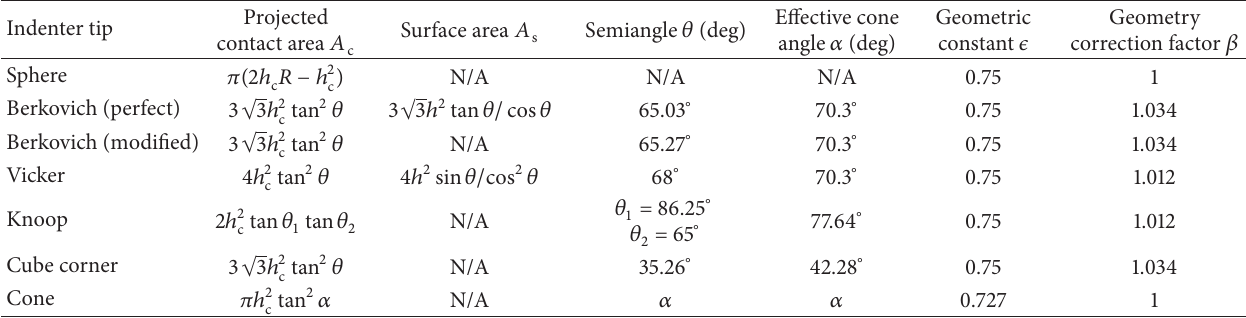
Figure 1: (a) Schematic representation of load-displacement curve in nanoindentation testing. (b) Schematic representation of cross section through indentation of a material sample. Table 1: Projected contact area, surface area, angles, geometric constants, and geometry correction factors for common indenter geometries [55] where ℎ c is the contact depth (shown in Figure 1(b)), ℎ is the indentation depth under applied force 𝐹 (see Figure 1(a)), 𝑅 is the radius of spherical tip, 𝜃 is the semiangle of indenter tip (for pyramidal tips 𝜃 is the face angle with the central axis of the tip [55]), 𝛼 is the half angle defining an equivalent cone, 𝜖 is the geometric constant (for the pyramidal tips 𝜖 is theoretically 0.72; however, a value of 0.75 has been experimentally found to better represent experimental data [55]), and 𝛽 is the geometry correction factor used for the determination of elastic modulus [53]. Note that 𝐴 c and 𝐴 s given in Table 1 for Berkovich, Vicker, Knoop, cube corner, and cone indenters are, respectively, the projected and surface areas of a perfectly sharp indenter without imperfection/bluntness (see, e.g., [53, 55], for the projected contact area of a blunt